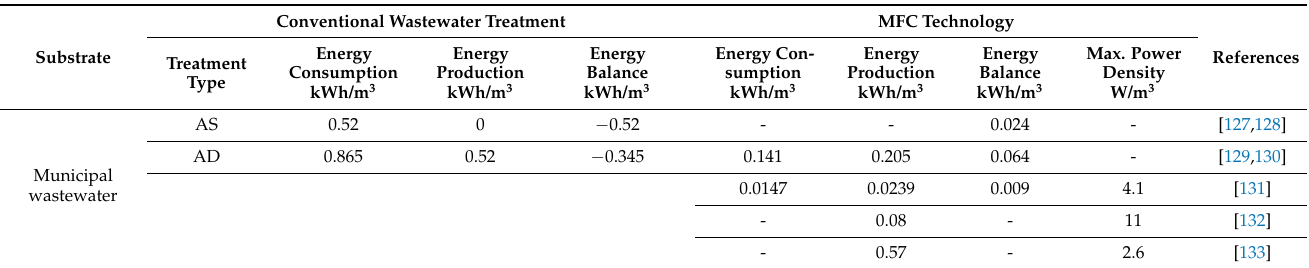
Table 3. Comparison of energy balances in real wastewater—conventional treatment methods vs. MFC